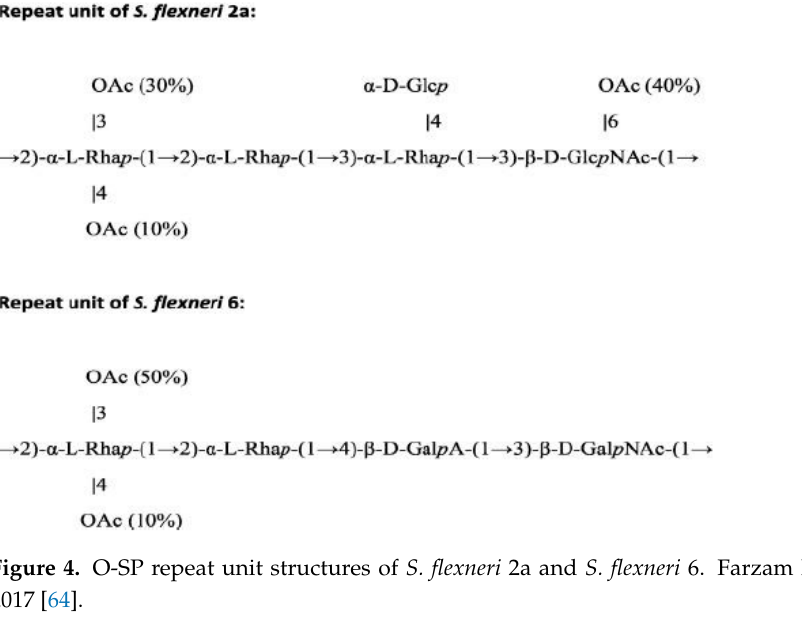
Figure 4. O-SP repeat unit structures of S. flexneri 2a and S. flexneri 6. Farzam N. et al. Vaccine 2017 [64].